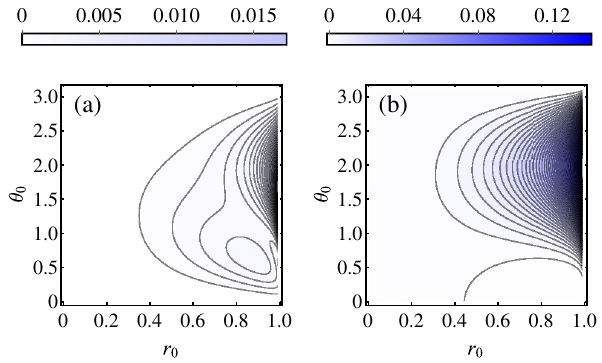
FIG. 7. Contour plot of (a) the tightness indicator δ WY γ of the bound specified by the Wigner-Yanase information metric and (b) the difference Δ δ γ ≡ δ QF γ − δ WY γ between the tightness param- eter corresponding to the quantum Fisher information metric and the one corresponding to the Wigner-Yanase information metric, for the amplitude damping process as a function of r 0 and θ 0 , for Γ τ ¼ 10 . The QSL constructed with the Wigner-Yanase skew information is nearly globally optimal (as δ WY γ ≃ 0 ) and tighter than the one constructed with the quantum Fisher information (as indicated by Δ δ γ ≥ 0 ) in almost the whole parameter space, except for a small region in the bottom-right corner (large r 0 , small θ 0 , i.e., around the state j 0 i ) in which the quantum Fisher information bound is marginally